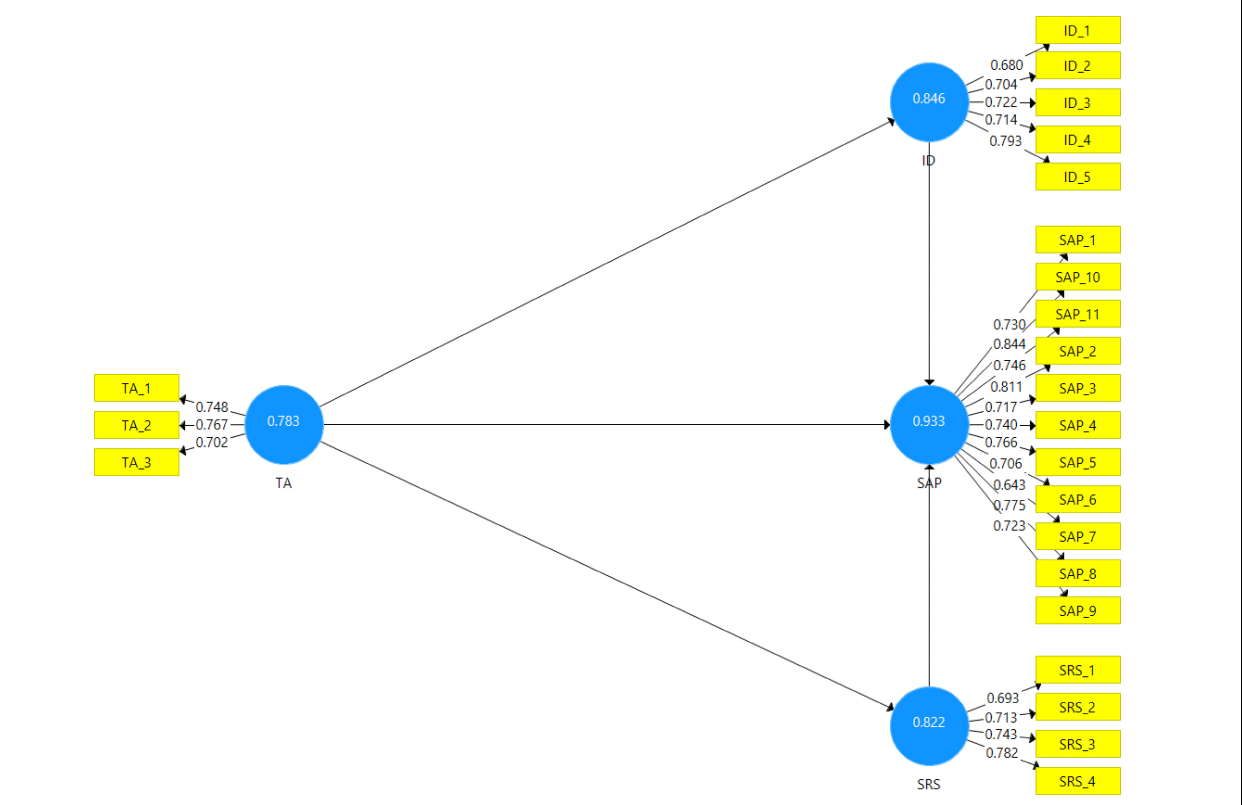
FIGURE 2 | Graphical representation of assessment of measurement model.